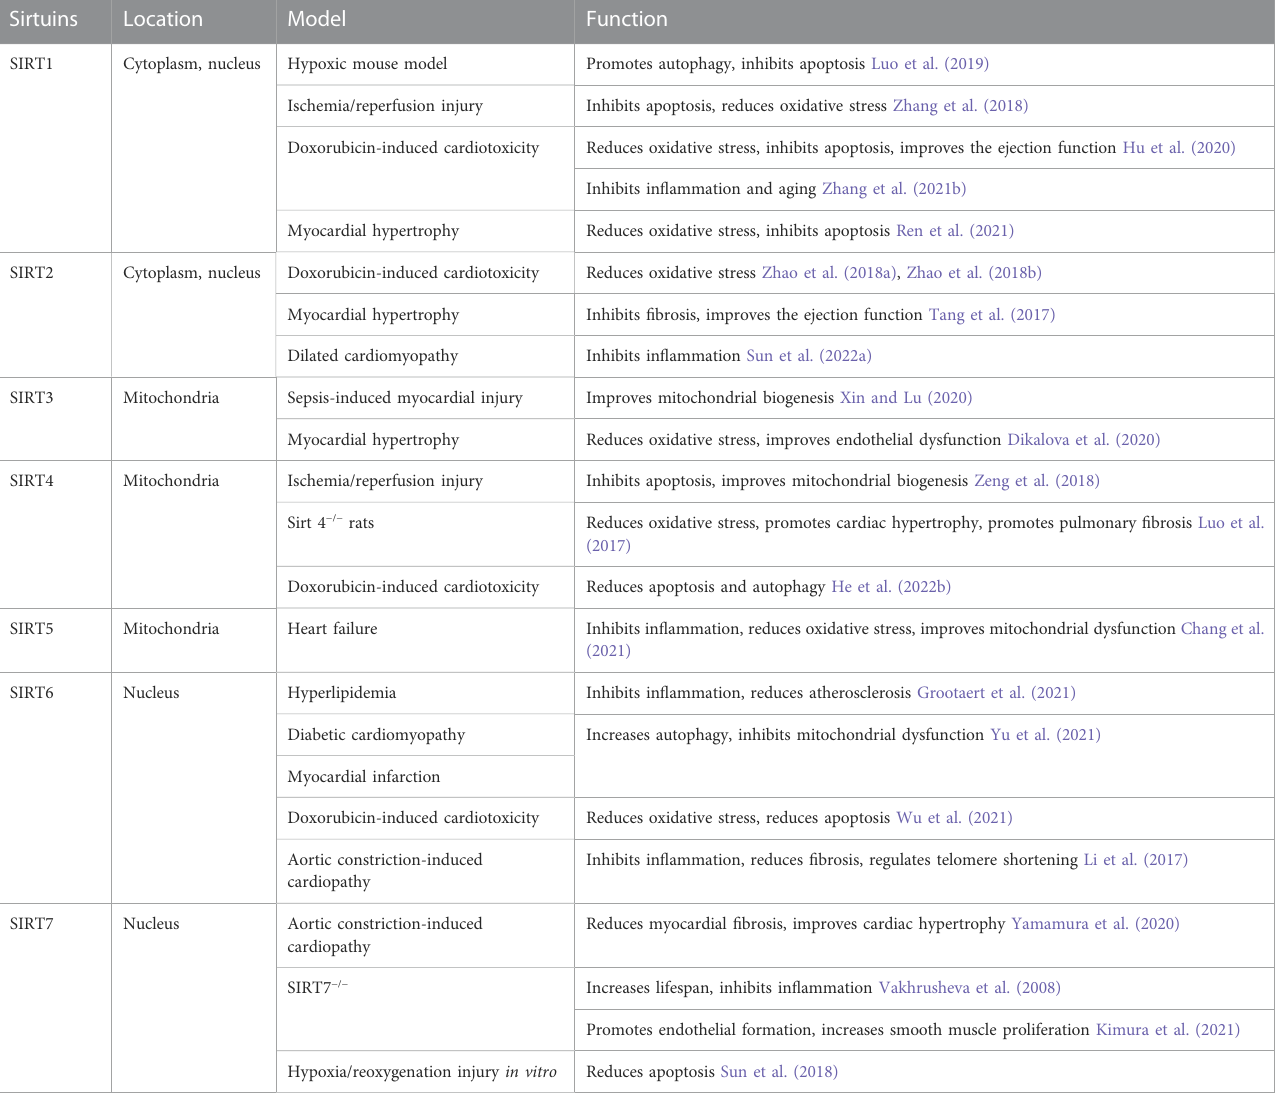
TABLE 1 Type, location, and function of various